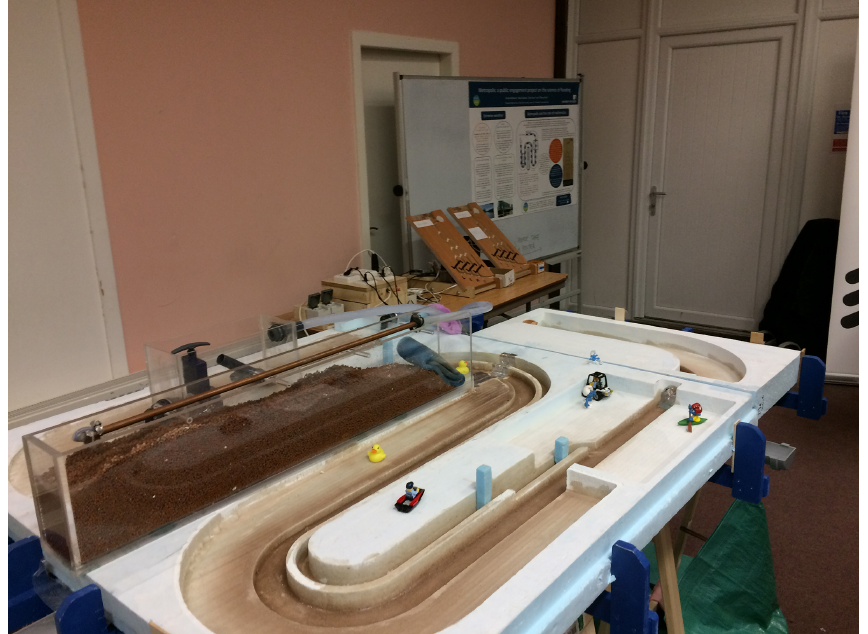
Figure 8. Photograph of the entire set-up at the Churchtown Flood Action Group workshop on 28 January 2017, with the winding river channel in the foreground, the city plain with a few smurfs, the groundwater moor, the reservoir on the left behind the moor, and, in the background on the right, the control table with the Arduino units and the two Galton boards as well as an informative poster on